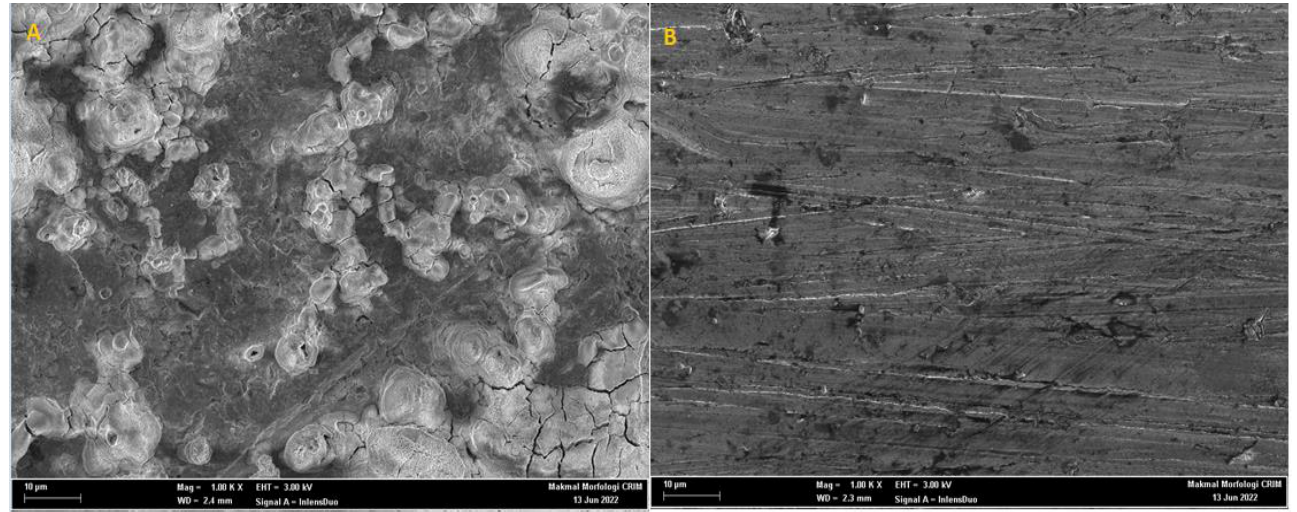
Figure 10. SEM micrographs showing the surface morphology of mild-steel-coupon surface in absence ( A ) and presence ( B ) of 0.0005 M PMBMH in 1 M HCl environment for 5 h at 303 K.